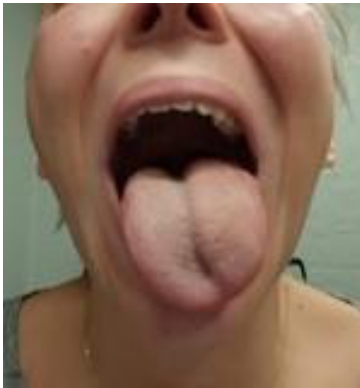
8 of 14 Figure 5. Follow-up MRA of the head arteries: ( a ) follow-up TOF MRA at the level of the carotid canal entrance showing the resolution of the left ICA stenosis (arrow); ( b ) follow-up TOF MRA demonstrating the reduction in the size of the left ICA false aneurysm (arrow); ( c ) fat saturated T1- weighted image showing small residual intramural thrombus in the left ICA (arrow). 2.6. Neuro-Logopaedic Therapy Before starting neuro-logopaedic therapy, the Frenchay Dysarthria Assessment scale revealed the following parameters: significant weakening of the cough reflex, a slight weakening of the swallowing and salivary reflexes, and an exorbitant gag reflex. Moreo- ver, the patient had correct lip movements but experienced breathing disorders while speaking and suffered from soft palate dysfunction. Length, pitch, and strength of phona- tion were reduced to a significant extent during the above-mentioned examination. It also revealed tongue deviating to the left side with significant limitation of lateral and upward mobility. In addition, it presented atrophy of the tongue and moderate impairment of spontaneous speech. As part of the therapy, we provided the patient with a special neurological massage of the sublingual muscles once a week. The stimulation started with the muscles located in the front part of the oral cavity. Then, after the gag reflex was reduced, the massage of the sublingual muscles located at the root of the tongue followed. As a result, the patient experienced an improvement in the clarity of spontaneous